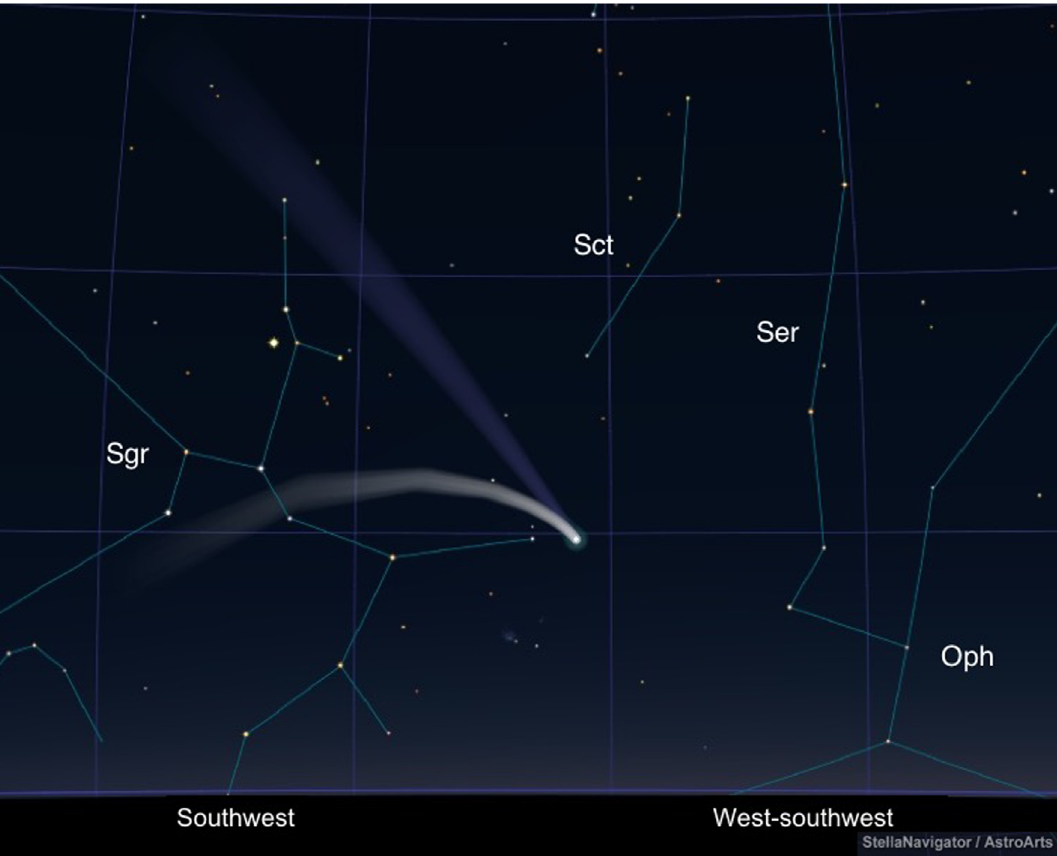
Fig. 5. Computed cometary tails at Safed on 1577 November 10, computed with the existing perihelion argument ( x = 255.673 (cid:3) ) (Woldstedt, 1844; Marsden & Williams, 2008) using Stellar Navigator